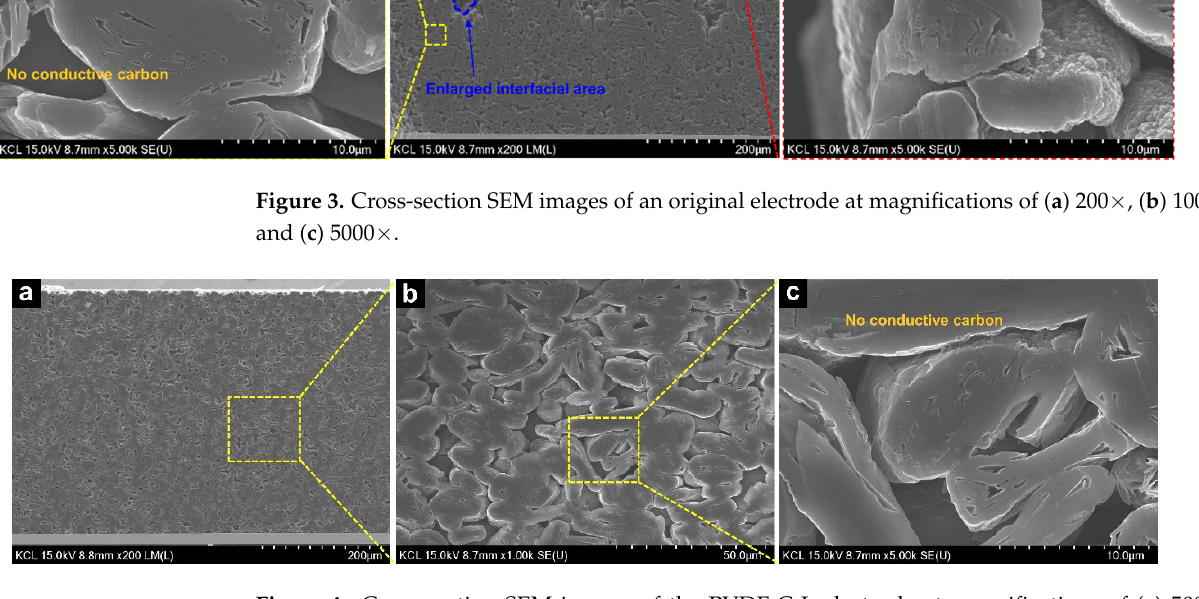
Figure 4. Cross-section SEM images of the PVDF-C-L electrode at magnifications of ( a ) 5000×, ( b ) 200×, and ( c ) 5000×.